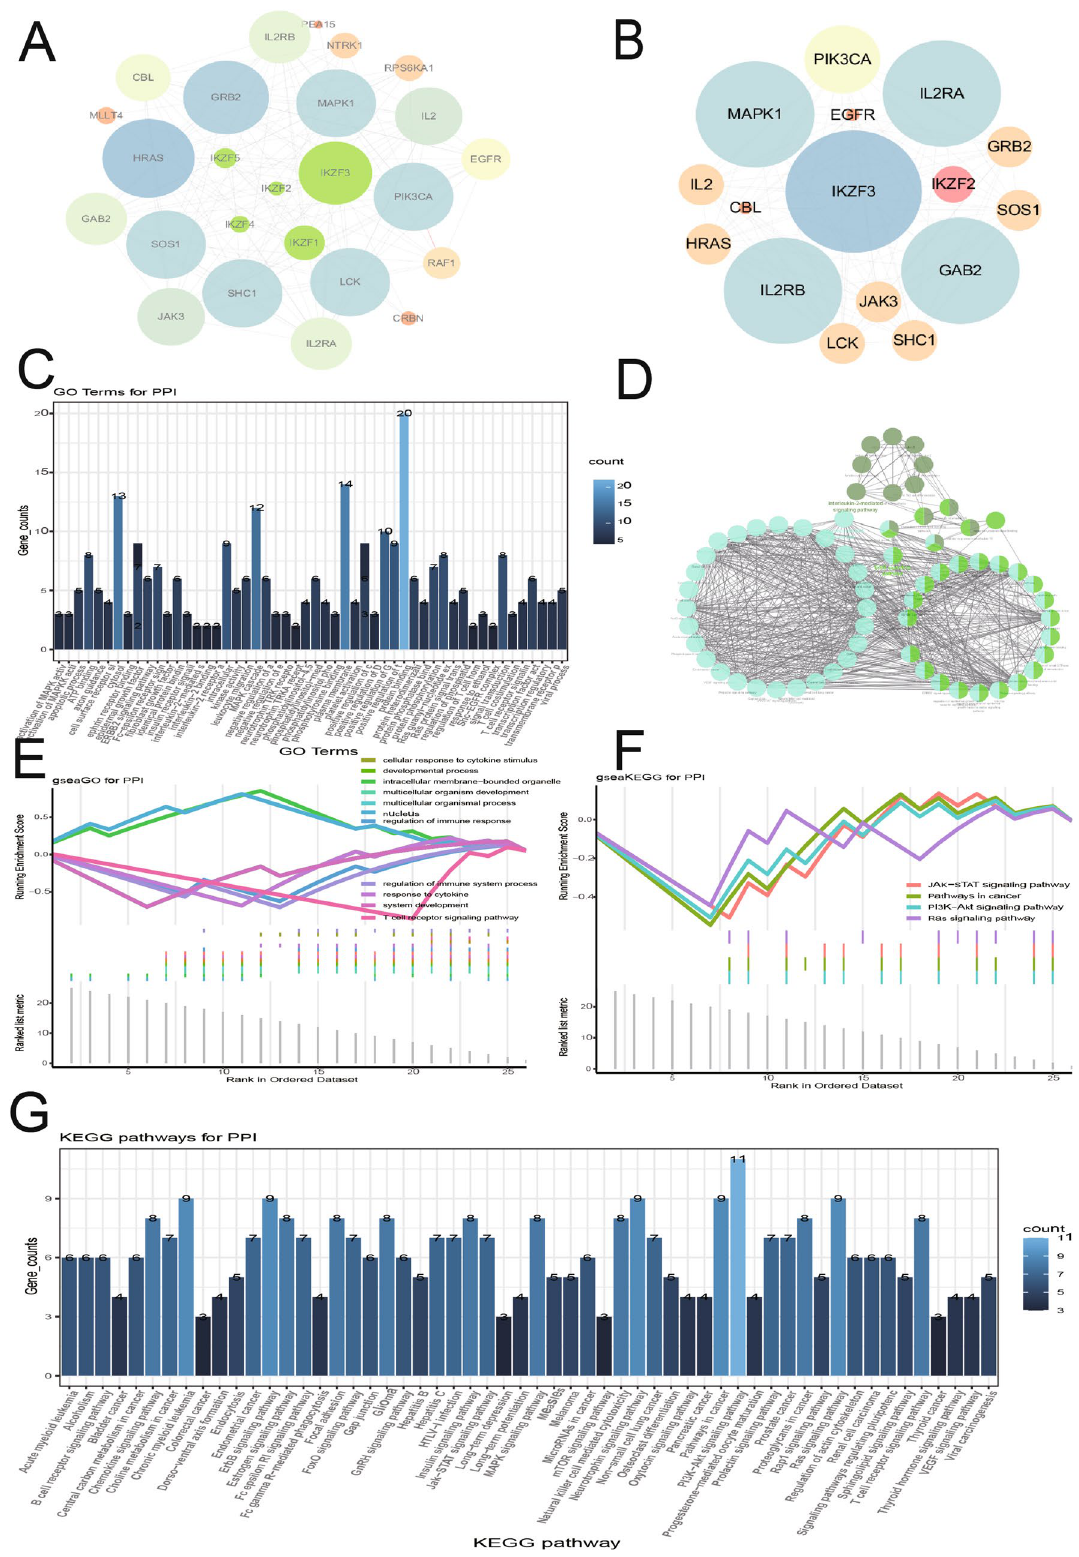
Figure 5. Protein–protein interaction network and its associated functional clusters. ( A ) STRING database was utilized to construct IKZF2 correlated PPI network. ( B ) Cytoscape was applied for visualization of the PPI network. Then, cytoscape plug-in MCODE was used to identify highly interconnected clusters and eventually the functional cluster 1 was obtained. ( C ) DAVID was adopted to annotate GO terms of special functional cluster from PPI network. ( D ) GO terms of the functional cluster 1 was annotated through ClueGO plug-in. ( E ), ( F ) GSEA was performed upon the genes involved in IKZF2 related PPI network. ( G ) pathway enrichment analysis on the genes of functional clusers from PPI network by the means of DAVID. Abbreviation, PPI protein–protein interaction network, GSEA gene set enrichment analysis, DAVID the Database for Annotation, Visualization, and Integrate